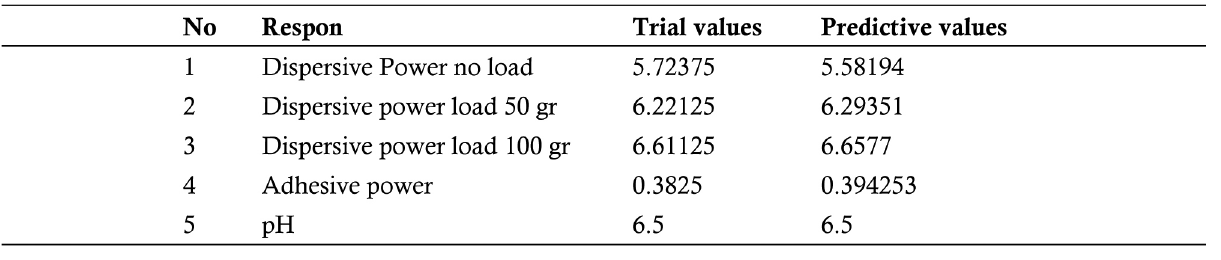
dispersion power. From expert design optimization using version 10 obtained optimum ratio tween span 80 to 80 compared to 4.5% compared to